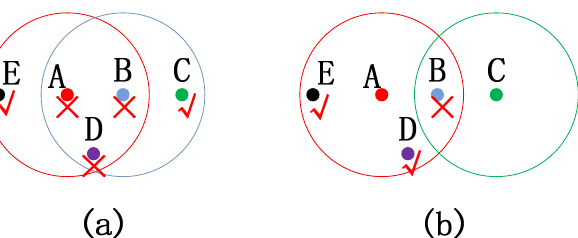
Figure 3. The two situations that can cause communication collisions. Dots denote sensor nodes, and the concentric circles with the same color indicate the node is broadcasting a message. A node with a check mark indicates it has received a message successfully, while a cross indicates it has failed to receive a message. Subfigure ( a ) exhibits communication collisions between a pair of first-order neighbors. Nodes A and B are a pair of first-order neighbors, and they are speaking simultaneously. In this situation, Nodes A and B fail to receive messages, while Nodes C and E receive messages successfully. Subfigure ( b ) exhibits communication collisions between a pair of second-order neighbors. Nodes A and C are a pair of second-order neighbors that are speaking simultaneously. Node B is the first-order neighbor of both A and B. Node B receives both signals at the same time, so it is unable to parse messages in either of the signals.